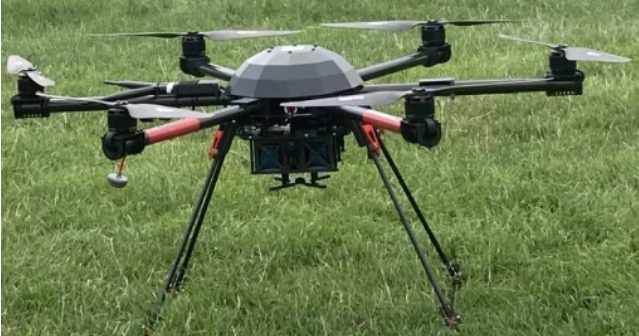
Figure 3. Airborne robotics modelled Air6 UAV